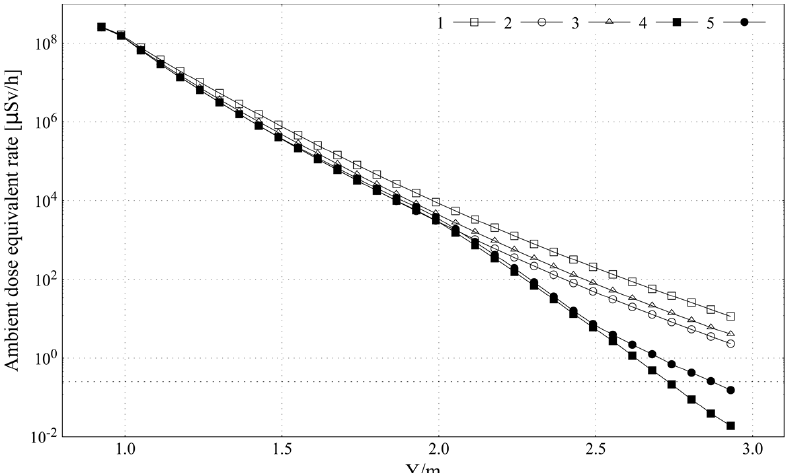
Figure 10. Average dose rate attenuation in different configurations with the elevation of the top shielding. The bullets (1, 2, 3, 4, 5) correspond to the number of five different combinations of shielding materials illustrated in Figure 9.